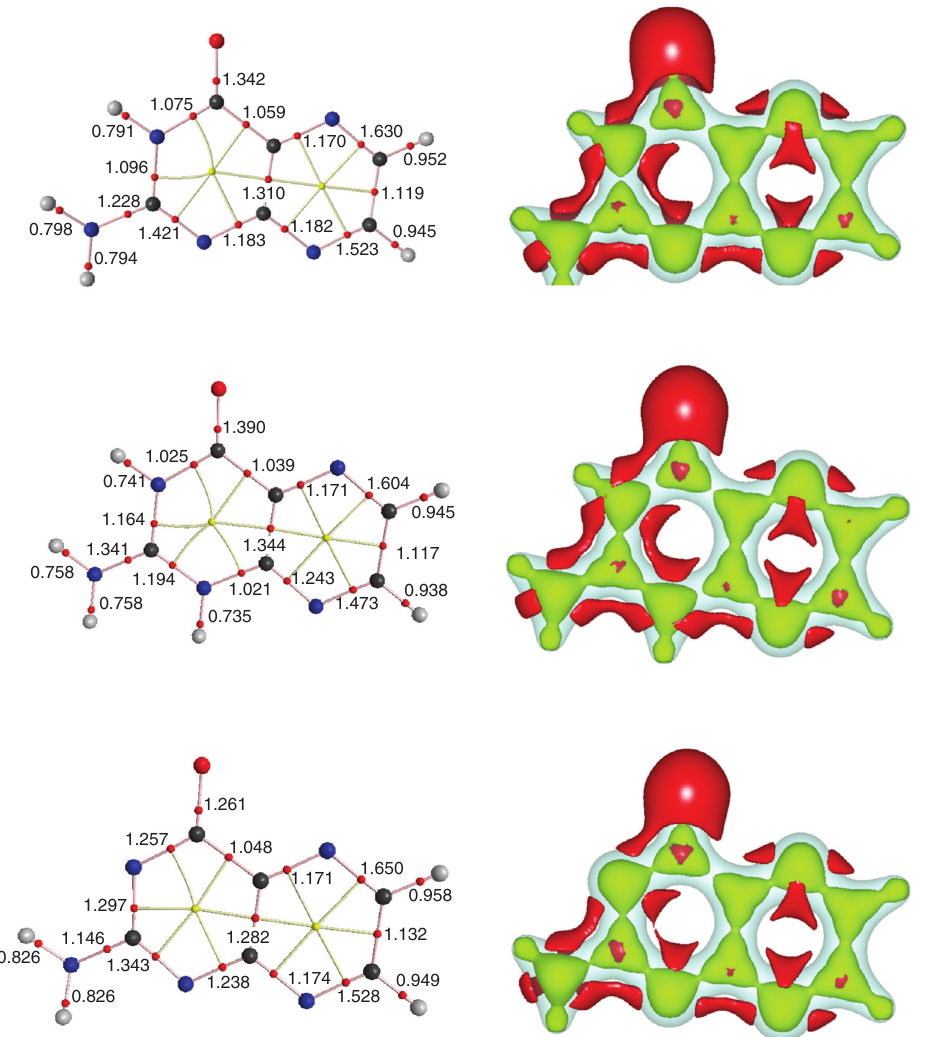
Figure 4 QT-AIM bond orders (left column) and visualizations of the electron density functions and their Laplacians for neutral (top), cati- onic (middle) and anionic (bottom) pterin (right column). The molecules are represented by the isodensity surfaces at 0.15 a.u. of electron density function (transparent light-blue). Regions of electronic charge depletion (positive Laplacian) are shown as red isosurfaces at an isovalue of 1.0; regions of electronic charge accumulation (negative Laplacian) are shown as yellow isosurfaces at an isovalue of –2.6. For these visualizations, electron density function values are provided by program G09W using regular 192 × 192 × 192 cubes surrounding the molecular structures. The computation of the Laplacian functions is accomplished by the graphical visualization software AVS Express 5.3, acting directly on the data of the electron density